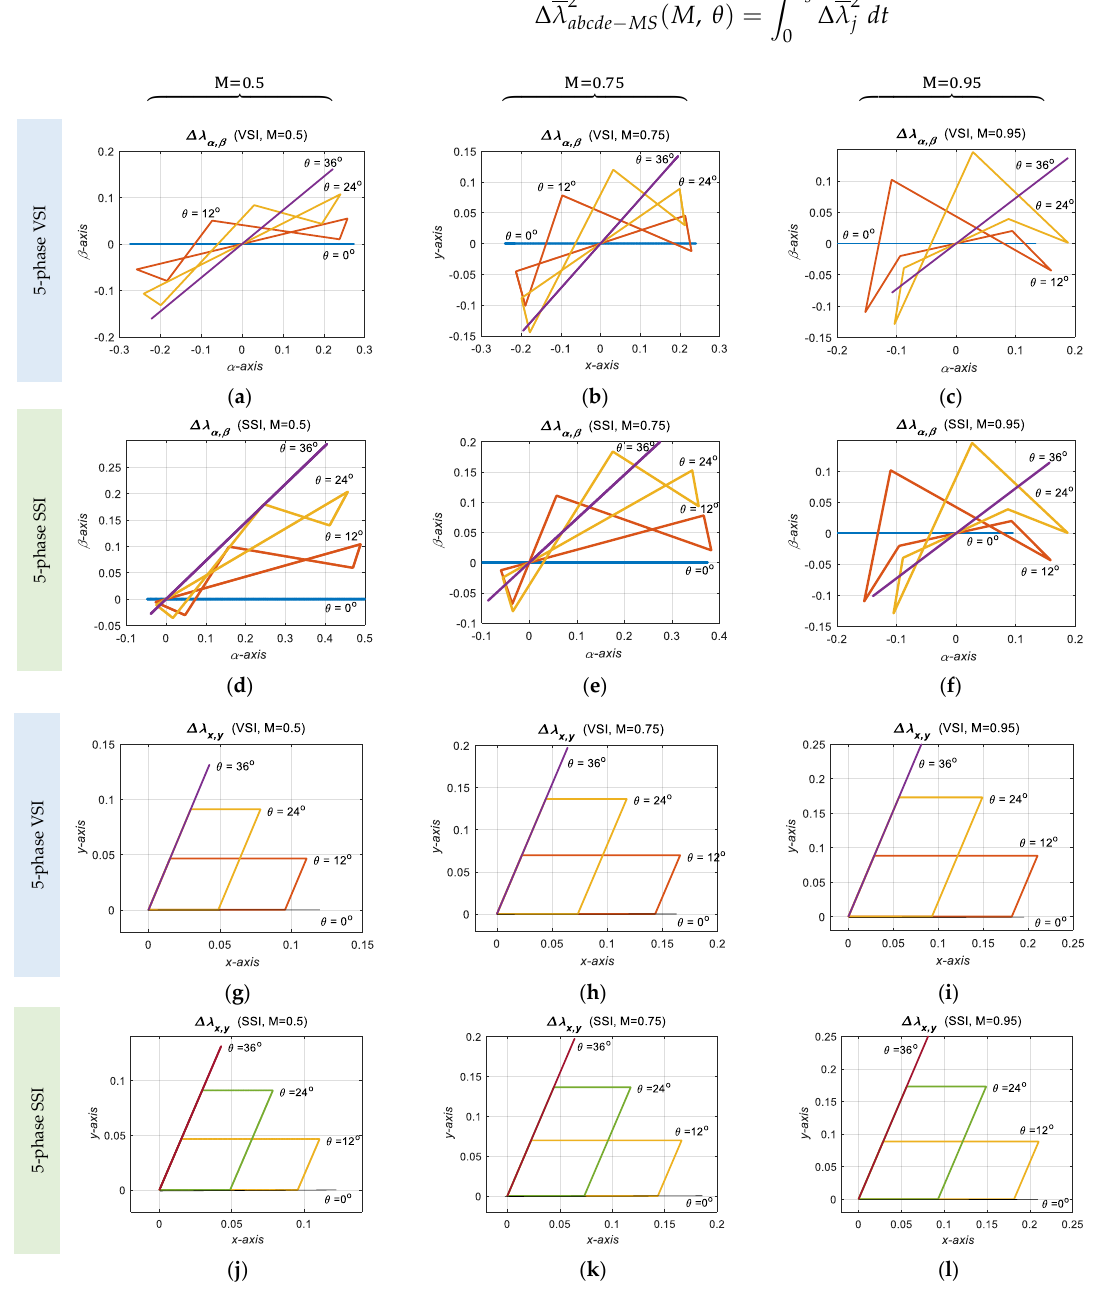
Figure 15. Error-voltage vector and harmonic-flux trajectory during the half of the switching cycle for VSI and SSI [26].